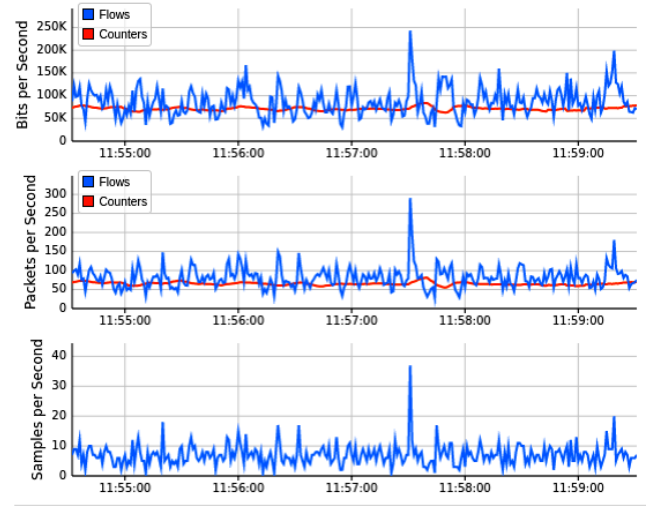
Figure 9. Performance dashboard for OF switches during normal traffic